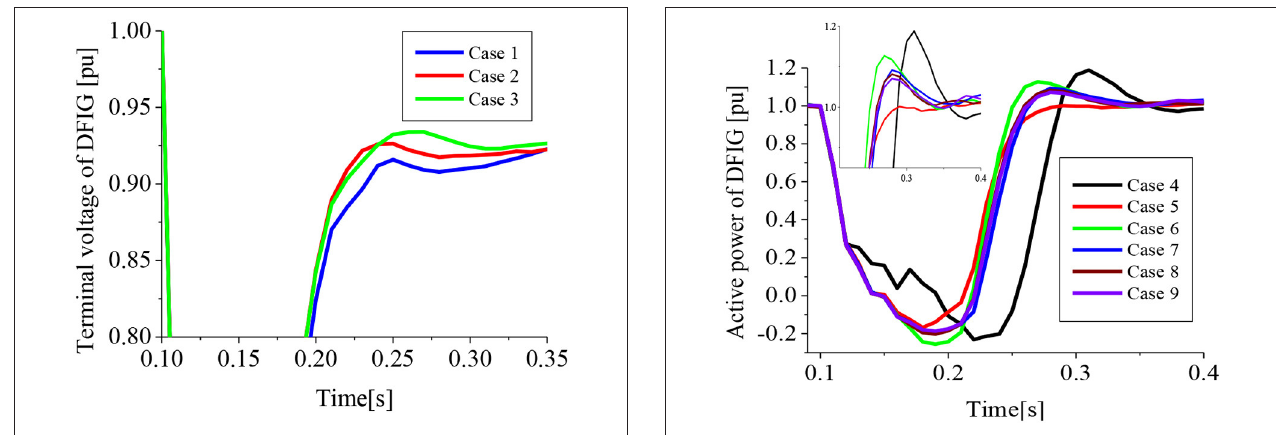
FIGURE 10 | Terminal voltage of DFIG (cases 1–3).